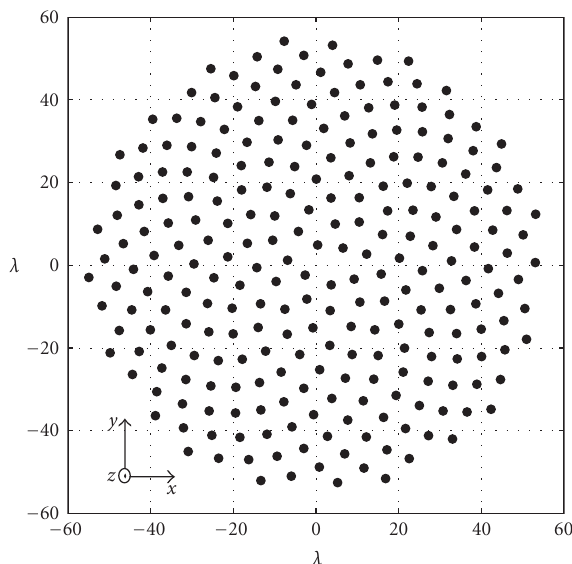
Figure 1: Distribution of the 250 elements in the uniform sunflower array antenna, as reported in [23].